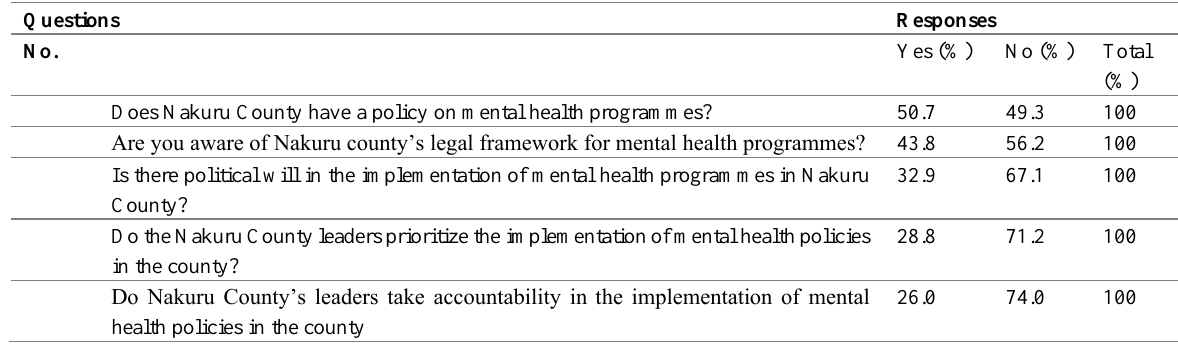
Table 1: County Legal